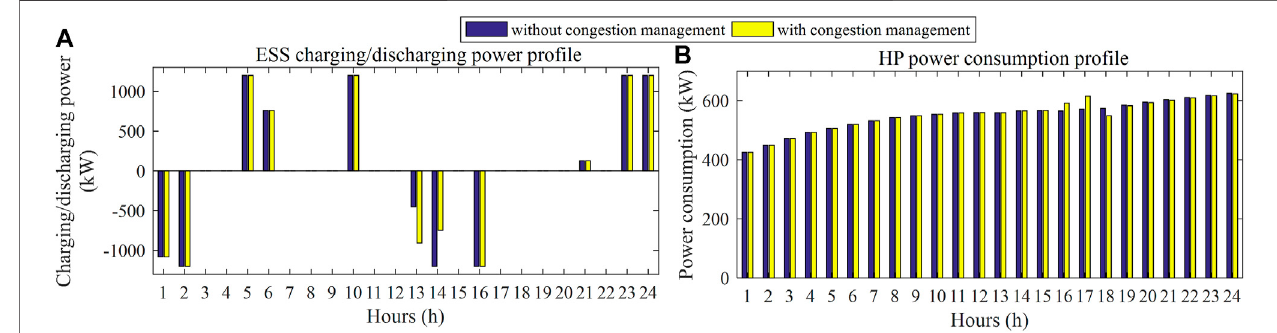
FIGURE 8 | (A) Comparisons of ESS charging/discharging power before and after congestion management in scenario 1, (B) comparisons of HP power consumption before and after congestion management in scenario 1.